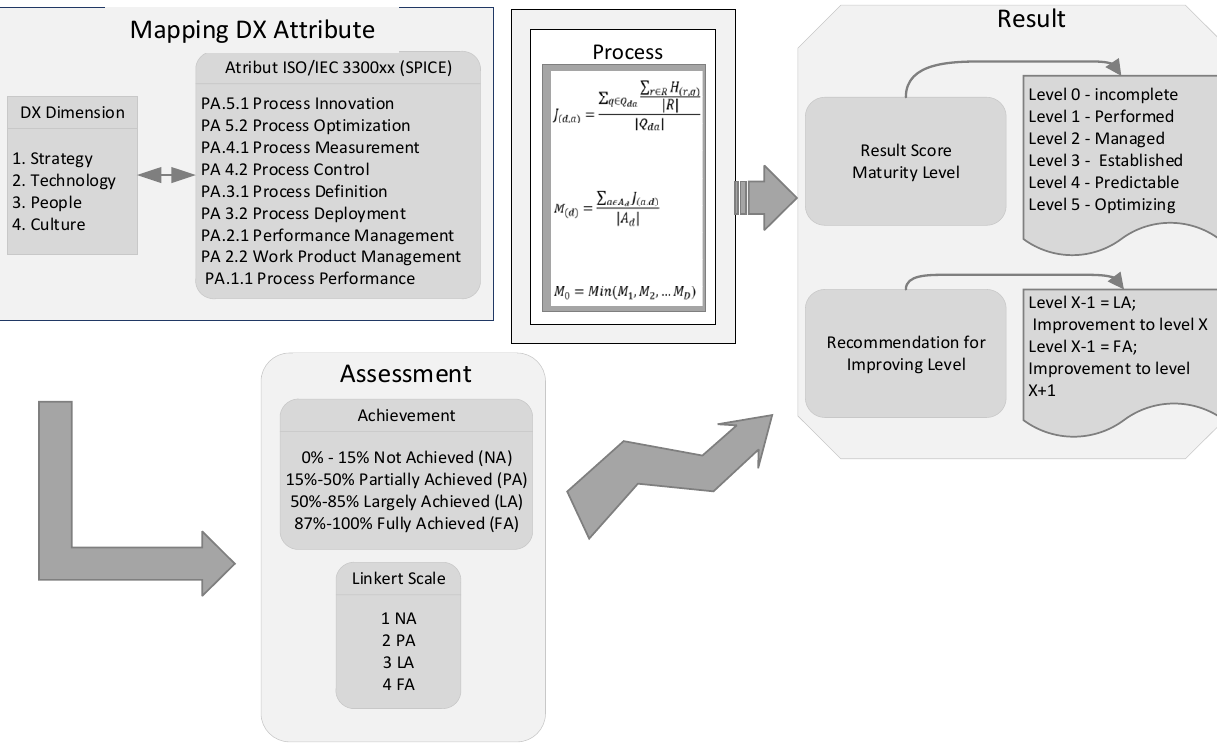
Figure 6. DX-SAMM Assessment Process.